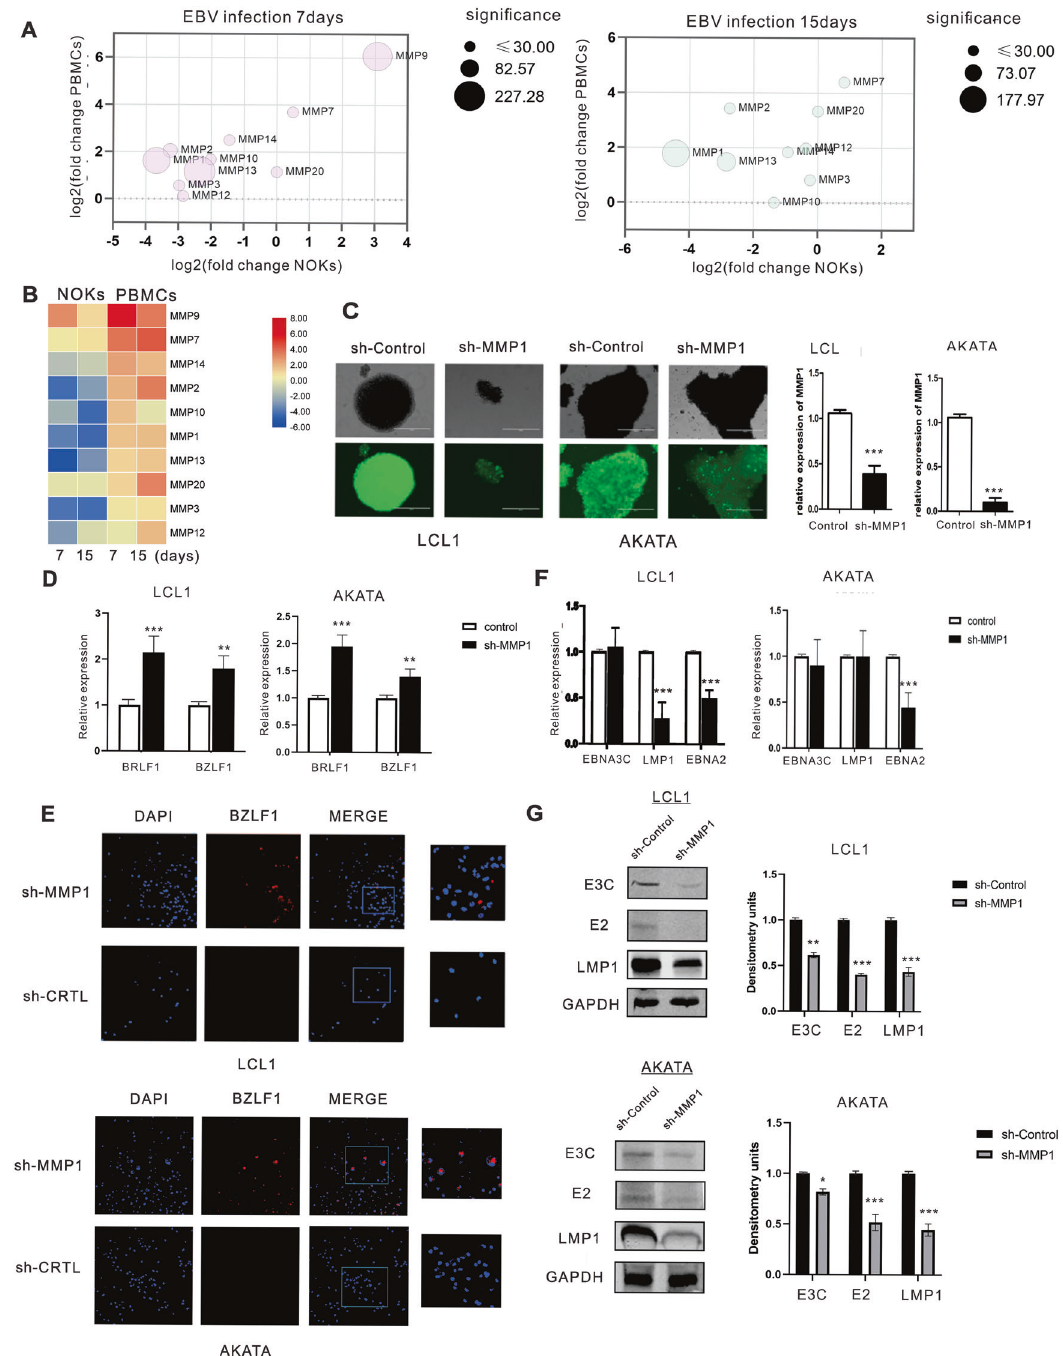
Fig. 5 The expression levels of MMP family showed an opposite trend in the two infection models and MMP1 is important for maintenance of the latent infection. Expression of the MMP protein family vacillate between the two infection systems and MMP1 is important for maintaining latency in epithelial cells. A Bubble plot that displays genes of MMP protein family. Axis values represent log 2-transformed fold change of transcript expression in PBMCs compared to NOKs. The size of the bubble corresponds to the log 10- transformed adjusted p-value to denote the statistical signi fi cance of differential expression. The fi gure shows that most of MMP protein family shows two distinct expression patterns after EBV infected NOKs and PBMCs. B Heat map of differentially expressed MMPs in NOK infected cells and PBMC infected cells. Heat map shows that most of MMPs exhibited a decreasing expression trend in infected NOKs, but they were up-regulated in infected PBMCs. C MMP1 knocked down LCL1 and AKATA cells were constructed by lentiviruses and selected by puromycin for three weeks. GFP fl uorescence was determined in the selected cells. Validation of MMP1 expression by real time-PCR. D Quanti fi cation of lytic gene BZLF1 and BRLF1 mRNA from three experiments is shown. E Immuno fl uorescence staining was performed to detect BZLF1 expression in LCL1 and AKATA cells. F Quanti fi cation of latent gene EBNA3C, LMP1 and EBNA2 mRNA from three experiments is shown. G The expression of EBV latent proteins was detected in MMP1-knockdown LCL1 and AKATA cell lines with WB. The relative density (RD) of protein was quantitated and